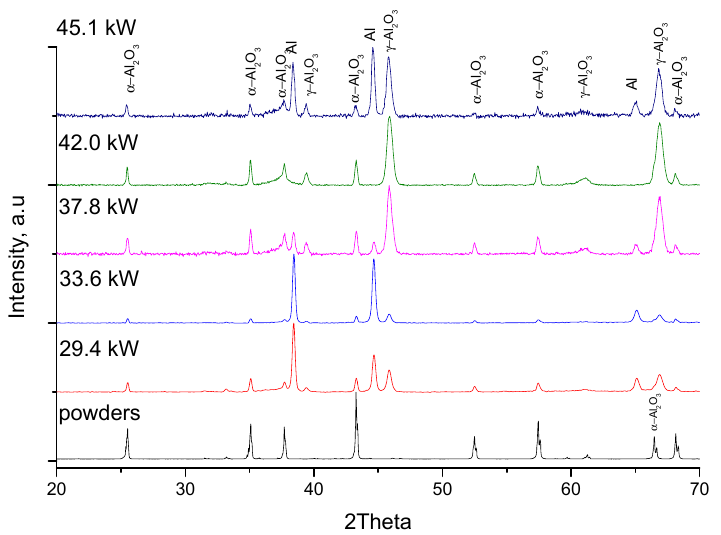
Figure 7. X-ray diffraction pattern of Al 2 O 3 coatings formed using different plasma torch power parameters.